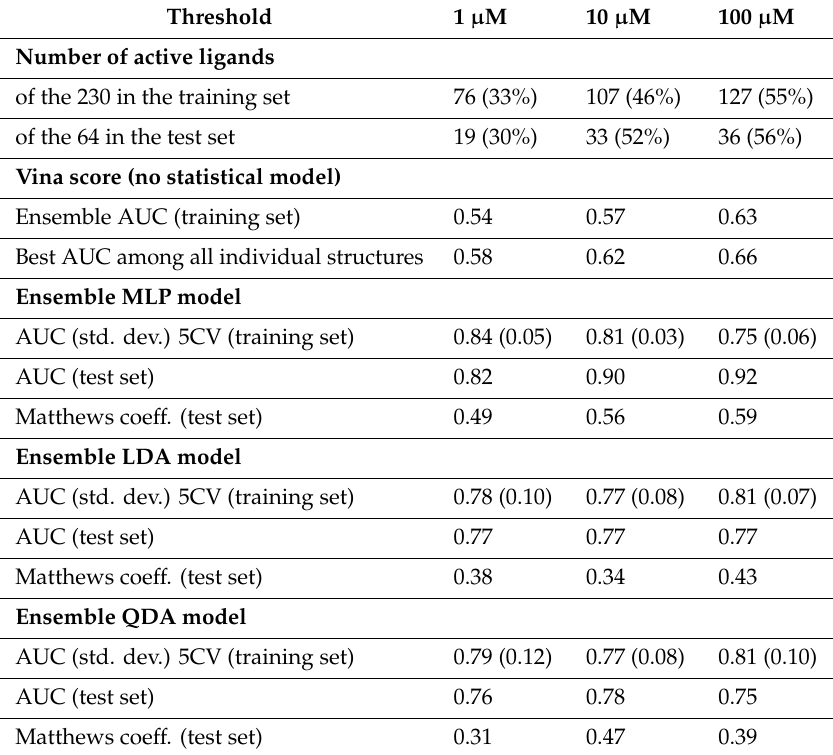
Figure 4. ROC curves showing the performance of the MLP classifier at a Ki threshold 10 µM, as measured on the test set. Table 1. Performance of the ensemble models (including the non-machine-learning score-only classifier) under di ff erent activity thresholds and machine learning